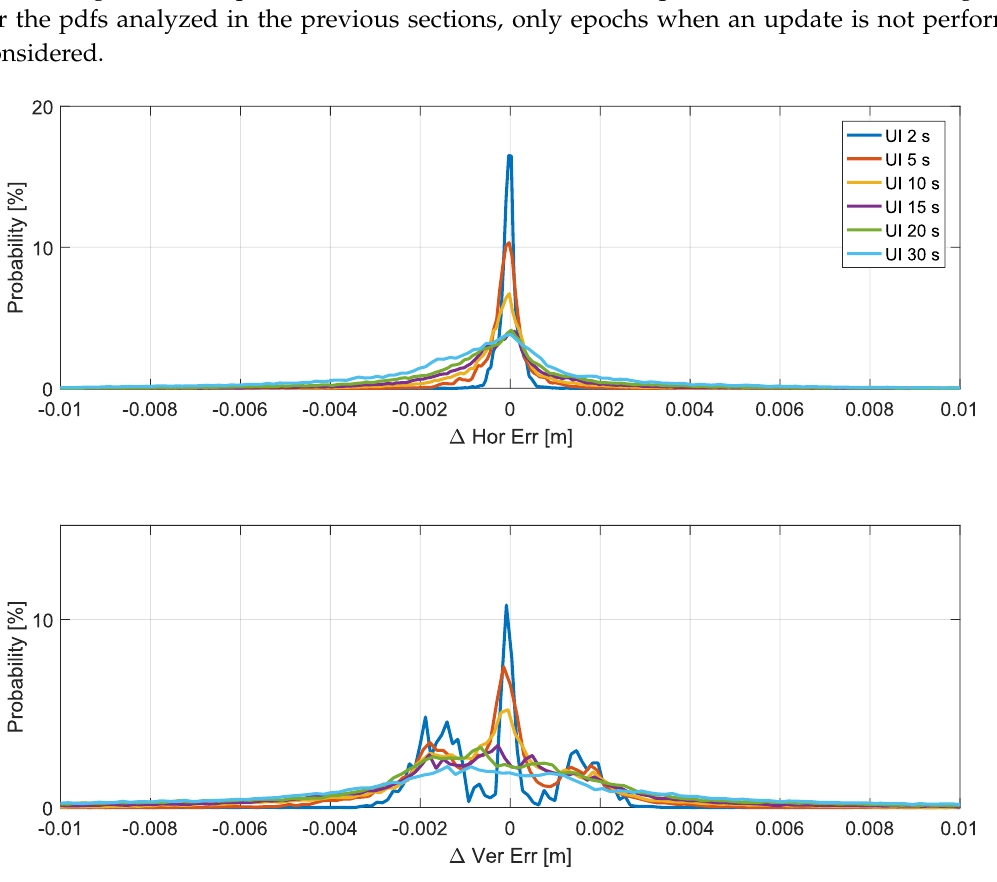
Figure 11. Empirical histograms of the position error differences for different update intervals. Upper: Horizontal position error differences. Lower: Vertical position error differences. Histograms have been represented with continuous lines to allow the superposition of different curves. In the legend, “UI” stands for “Update Interval”. The histograms have been computed considering epochs without updated